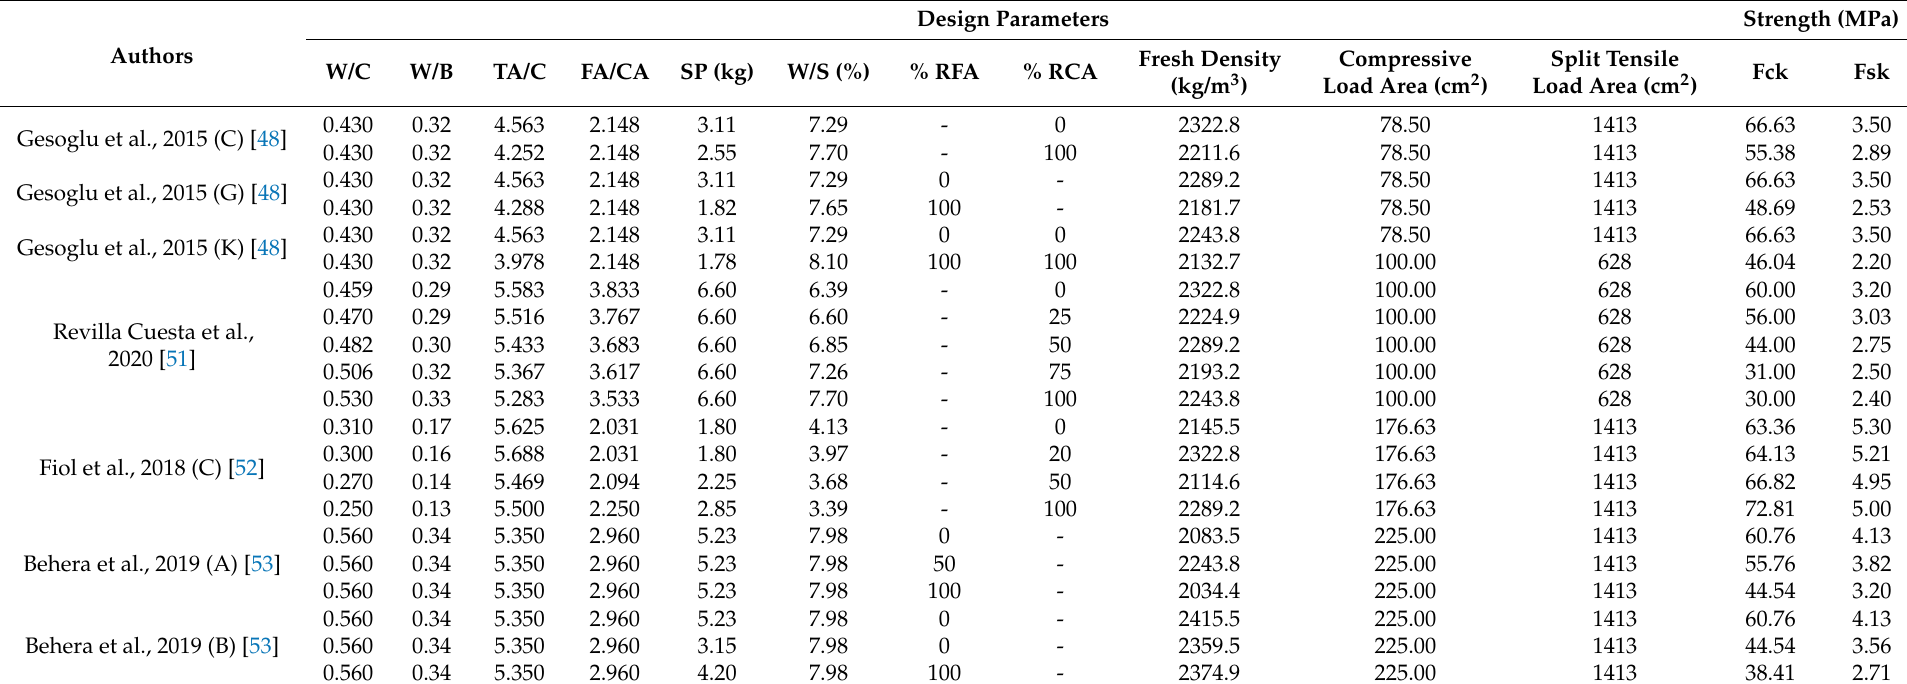
Table 2. Family II (Compressive strength range–60 MPa to 70 MPa) design parameters according to